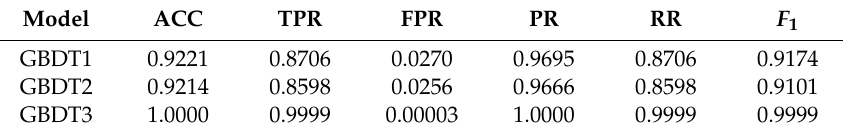
Table 9. Performance comparison of three models of 100 k WIDE UDP flow datasets.